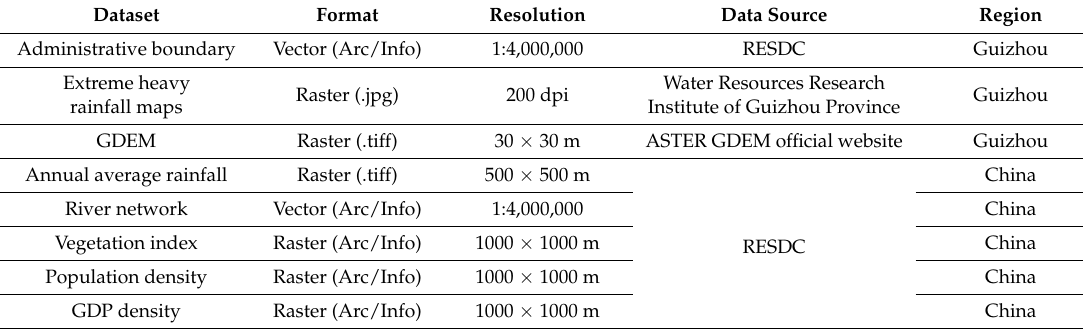
Table 2. Specifications of multi-source dataset employed in this